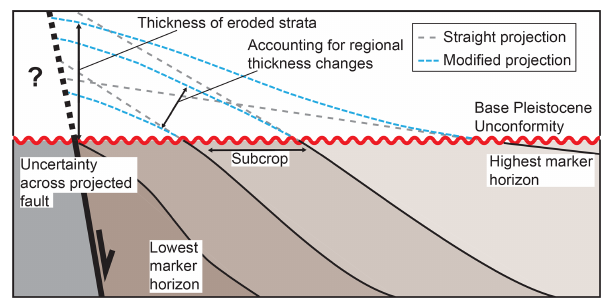
Figure 4. Schematic diagram showing how uplift is calculated by projecting truncated stratigraphy above an unconformity. Uplift es- timates based on straight and modified projections of strata are cal- culated. Where possible, measurements are taken at the largest pos- sible value; however, projections are not calculated across